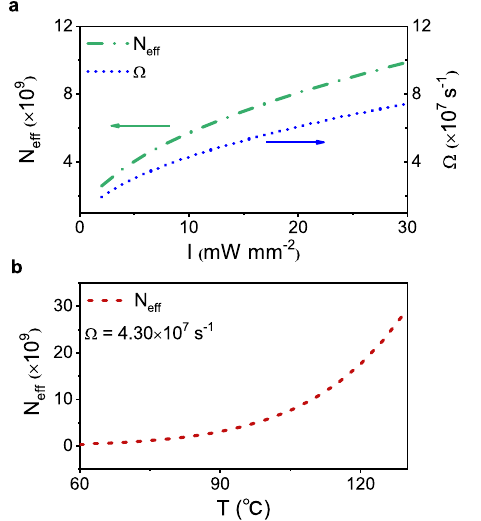
Fig. 8 Intracavity photon number n as a function of the phase shift Δ ϕ at different cavity-mirror re fl ectivity R values. Here, g = 1.99 × 10 5 s − 1 , Ω = 4.30 × 10 7 s − 1 , and N = 5.71 × 10 9 . The blue and red lines represent eff the photon number when the cavity is resonant and anti-resonant, respectively. The orange and the purple lines show the results at R = 34.5% and R = 80% ( n ≤